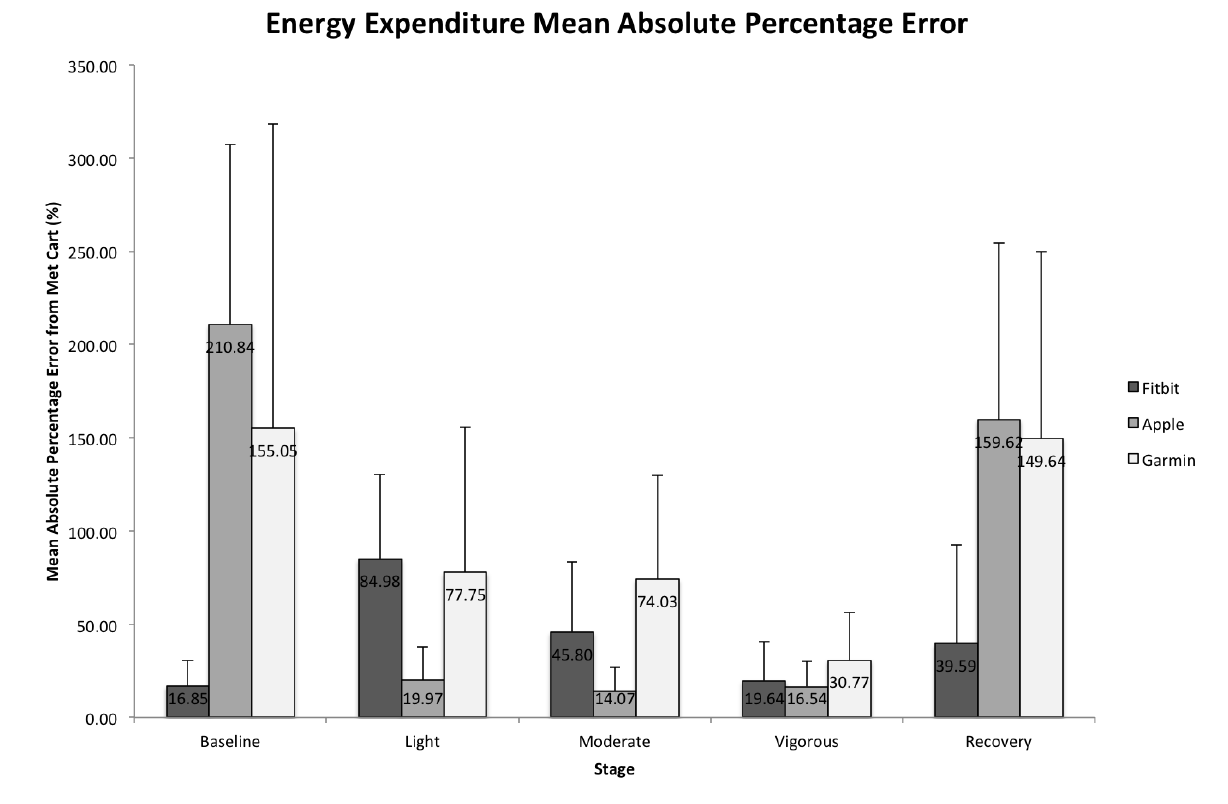
Figure 2. Mean absolute percentage error (MAPE; %) of the devices for energy expenditure from the TrueOne 2400 metabolic cart criterion. MAPE values are presented by exercise intensity per device. Error bars represent one standard deviation from the mean